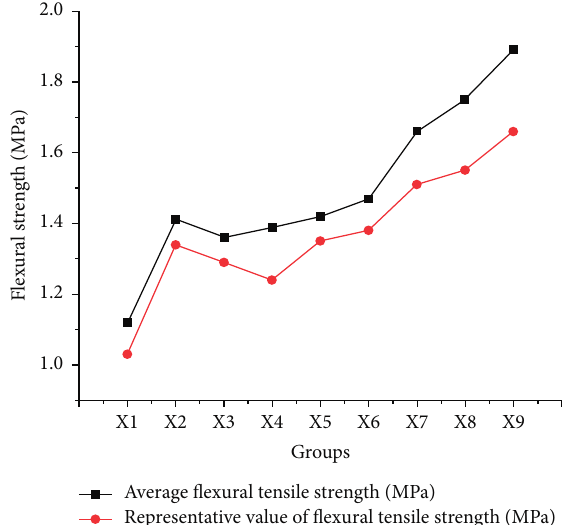
Figure 16: Flexural tensile strength test